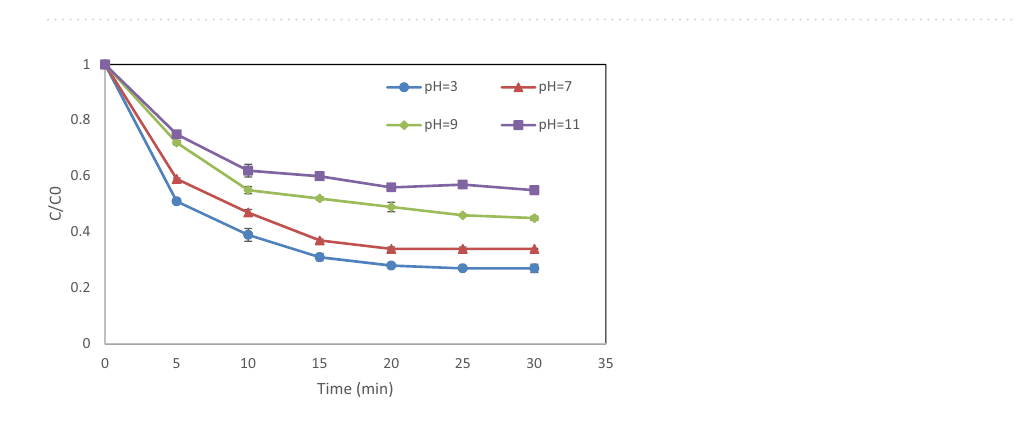
Figure 4. FTIR spectra of the MgO nanoparticles.